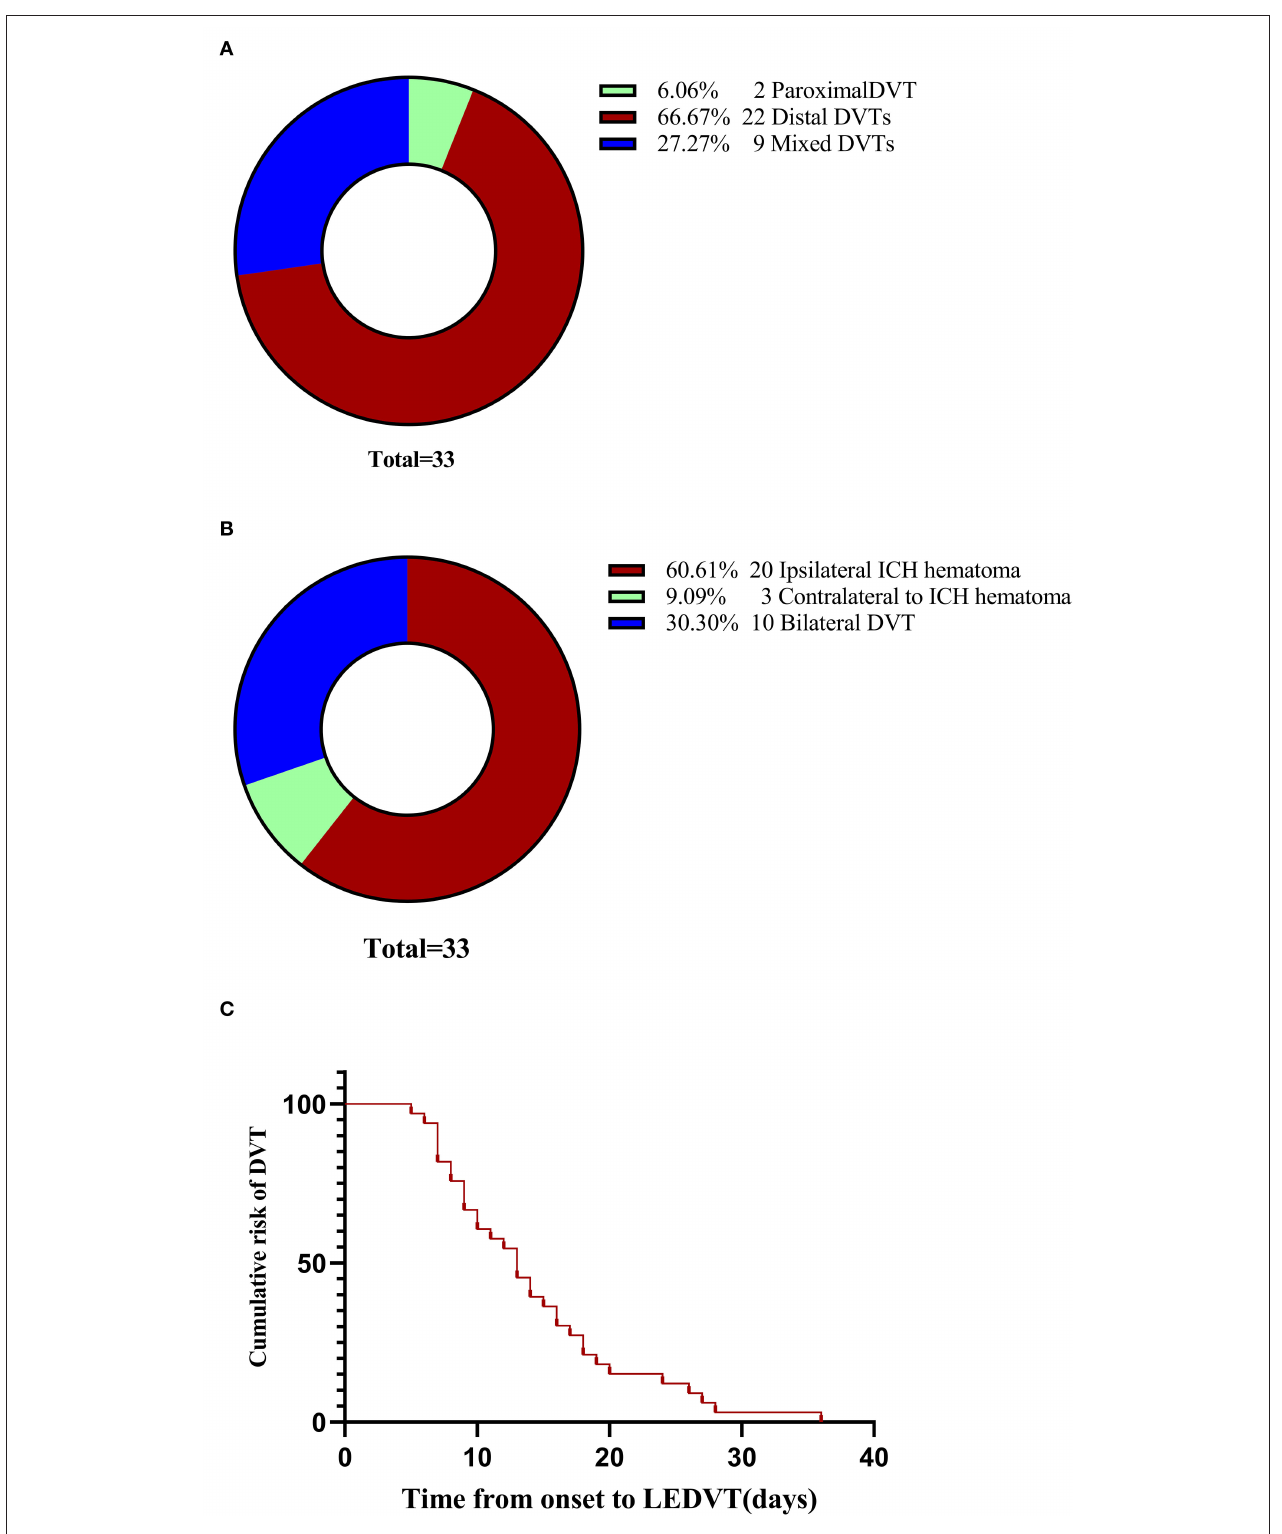
FIGURE 2 | LEDVT overall. (A) Pie chart showing the number and percentage of the three types of LEDVT. (B) Pie chart demonstrating the distribution, number, and percentage of LEDVT relative to the location of intracerebral hemorrhage hematoma. (C) Cumulative LEDVT rate using Kaplan-Meier analysis from intracerebral hemorrhage onset to LEDVT. LEDVT, lower-extremity deep venous thrombosis.